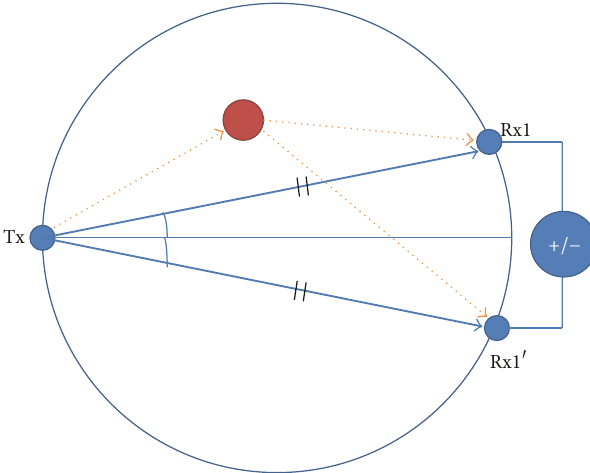
Figure 16: In-place calibration with dual